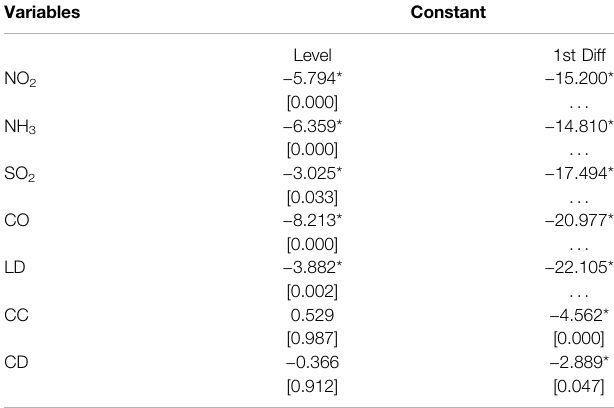
TABLE 2 | Augmented Dickey – Fuller (ADF) test results. TABLE 3 | Bound test